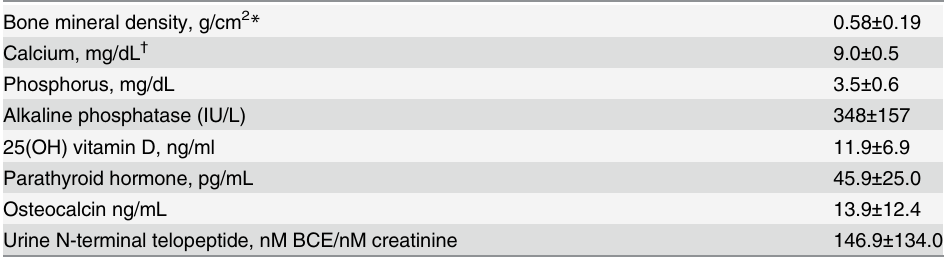
* Bone mineral density of lumbar spine 2 – 4 in anteroposterior projection and normal value based on diagnostic criteria for osteoporosis by Japanese Society of Bone and Mineral Research. † Serum calcium adjusted by